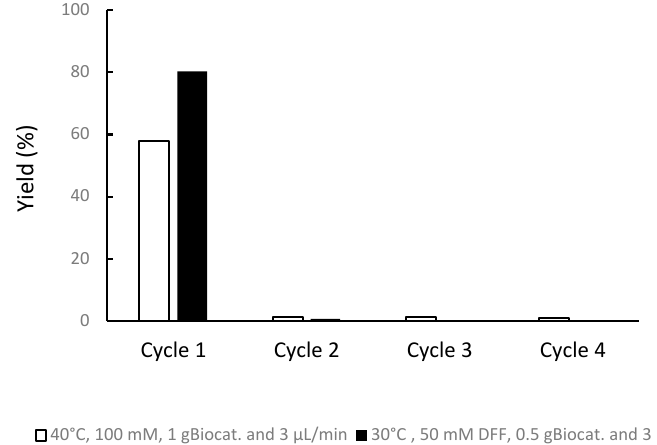
Figure 8. Operational stability of the biocatalyst in the chemoenzymatic oxidation for the synthesis of FDCA in fed-batch mode. Operating conditions: 10 mL of the reaction medium, 2043 µL of H 2 O 2 at a flow of 1.46 µL/min, and 24 h of reaction.